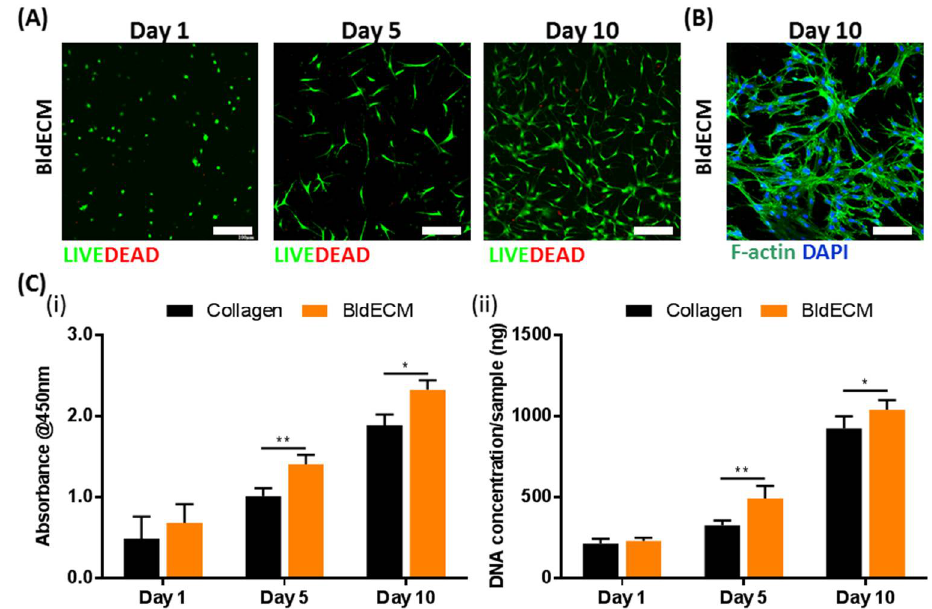
Figure 4. In vitro biofunctionality assessment of the hBMSCs-laden BldECM bioink. ( A ) Live/dead staining of hBMSCs in the BldECM for 10 days (scale bar = 200 μm); live cells (green), dead cells (red). ( B ) F-actin staining of the BldECM constructs on day 10 (scale bar = 100 μm); DAPI (blue, cell nuclei), F-actin (green, actin filaments). ( C ) Comparison of cell proliferation in collagen and BldECM groups for 10 days: ( i ) CCK-8 assay test and ( ii ) DNA quantification test (* p < 0.05 and ** p < 0.01).